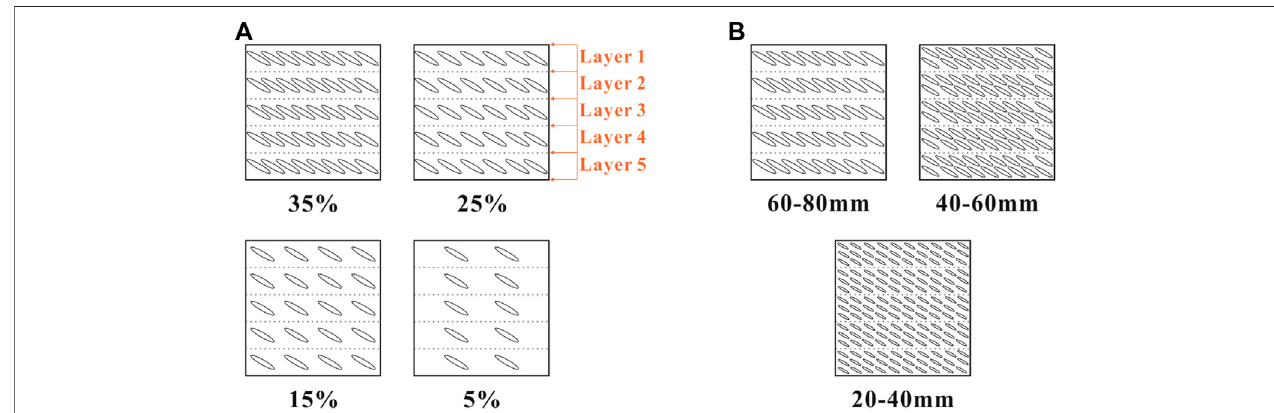
FIGURE 6 | Schematic diagram of the specimens. (A) Group G-1 specimens; (B) Group G-2 specimens.